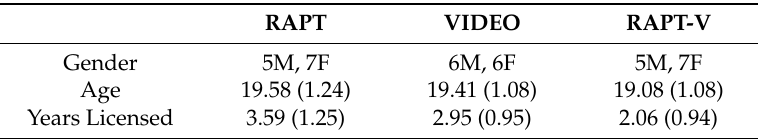
Table 2. Demographics information for the three groups. Numbers in parentheses indicate 1 standard deviation. M represents males and F represents